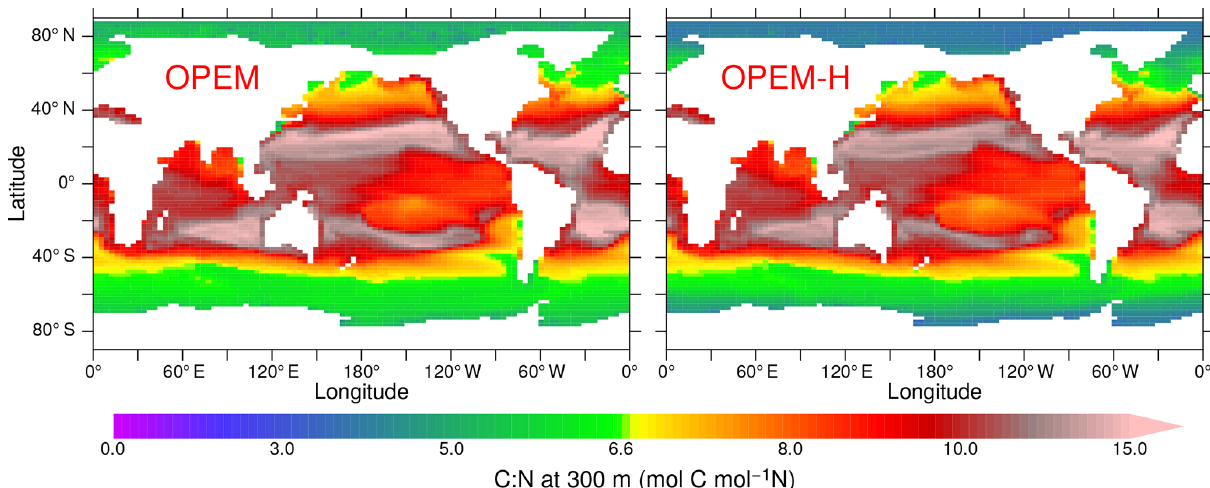
Figure 7. Annually averaged C : N ratio of detritus at 300m in the OPEM and OPEM-H simulations. The colour bar is centred at 6.625molC(molN) − 1 , which is the C : N ratio of zooplankton in all our UVic simulations.